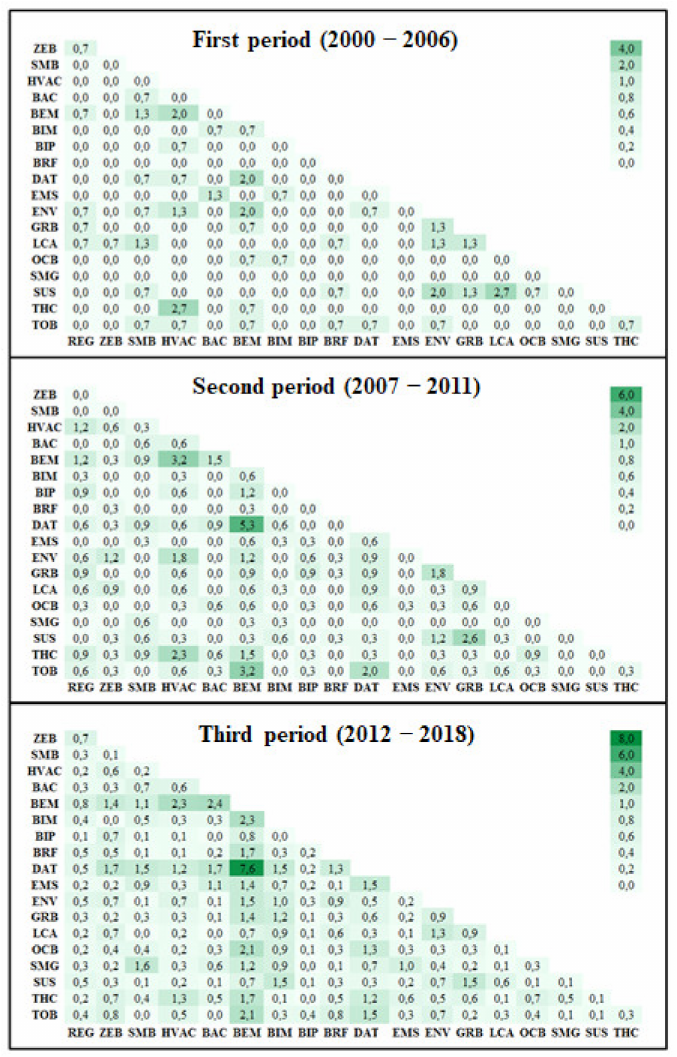
Figure 9. λ ij for each period (source: